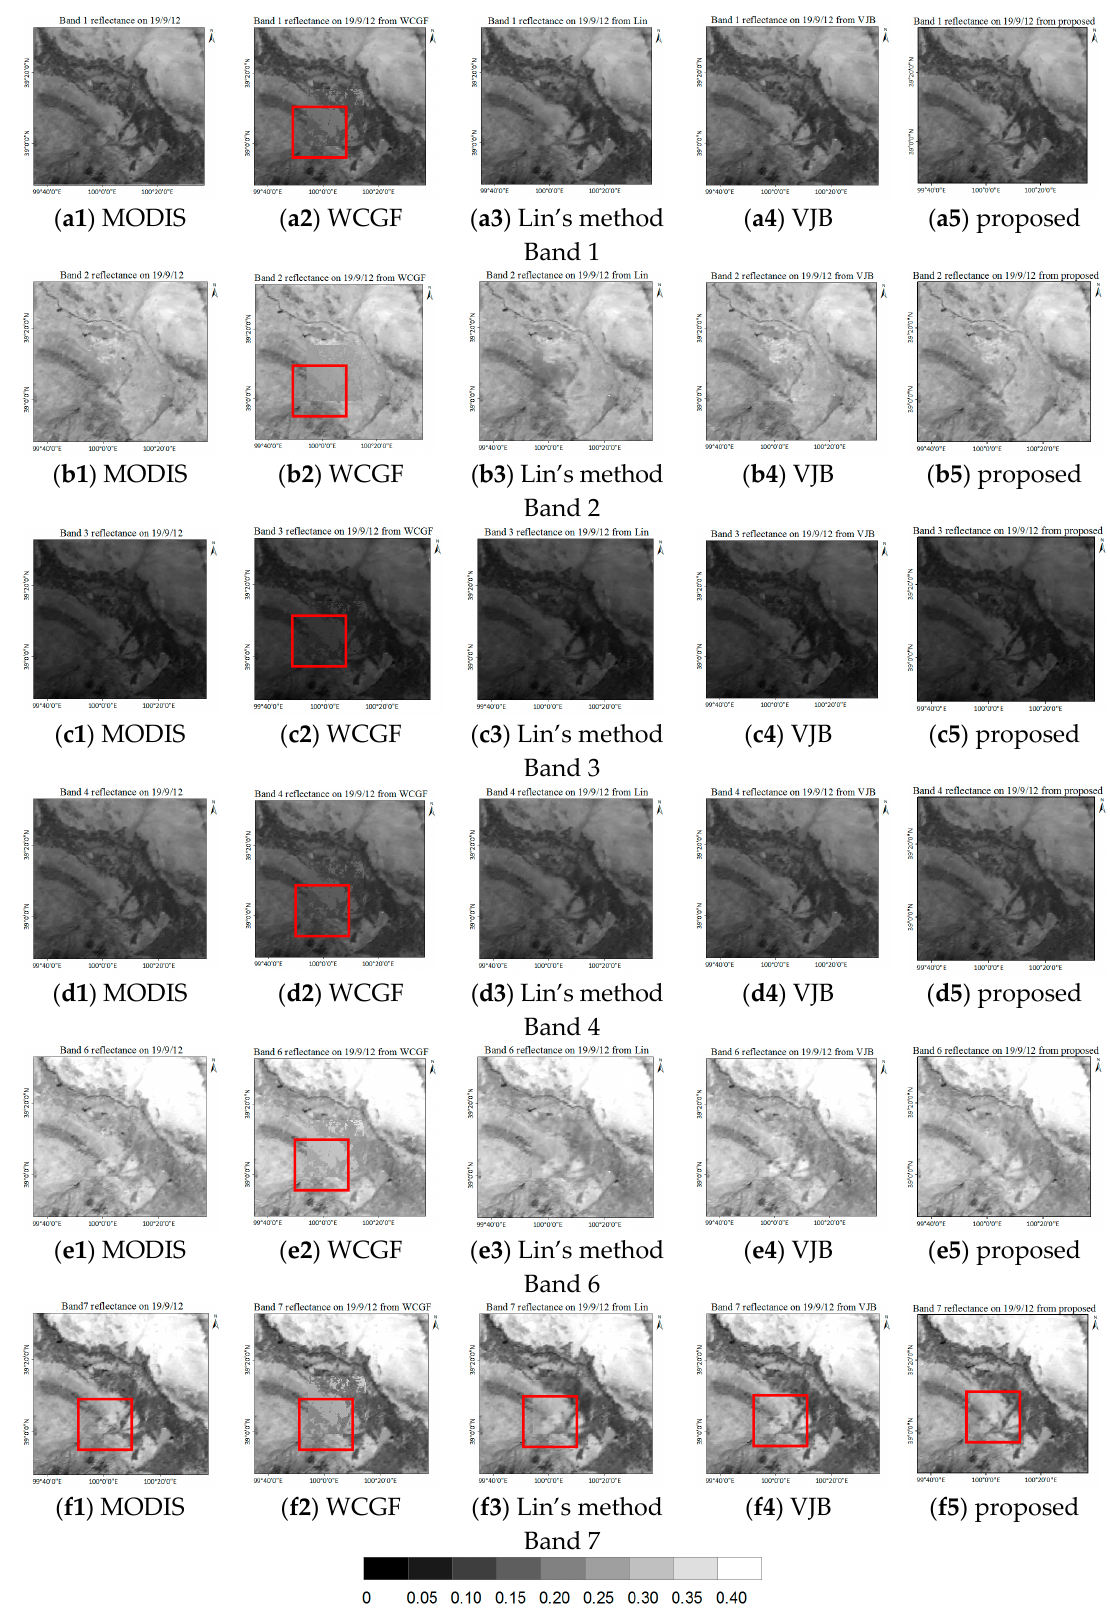
Figure 7. The spectral reflectance for MODIS bands 1, 2, 3, 4, 6, and 7 ( a1 – f1 ); and the retrieved spectral reflectance for MODIS bands 1, 2, 3, 4, 6, and 7 for: ( a2 – f2 ) WCGF; ( a3 – f3 ) Lin’s method; ( a4 – f4 ) VJB; and ( a5 – f5 ) the proposed method in the simulated cloud area from Figure 6b.